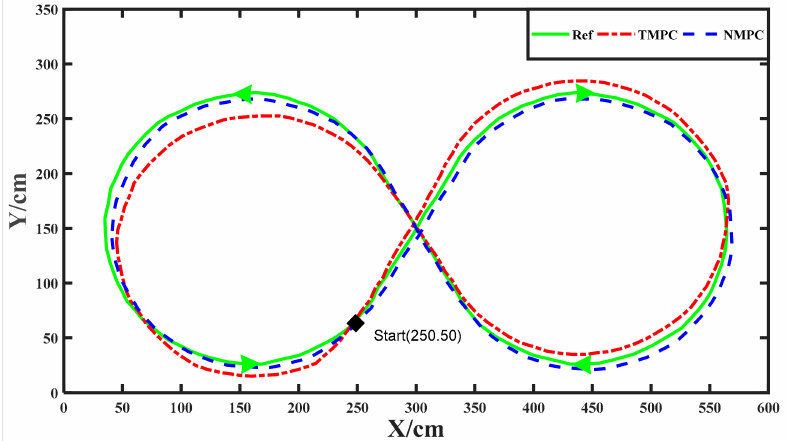
Figure 17. The tracking response curves of the two MPC controllers under the